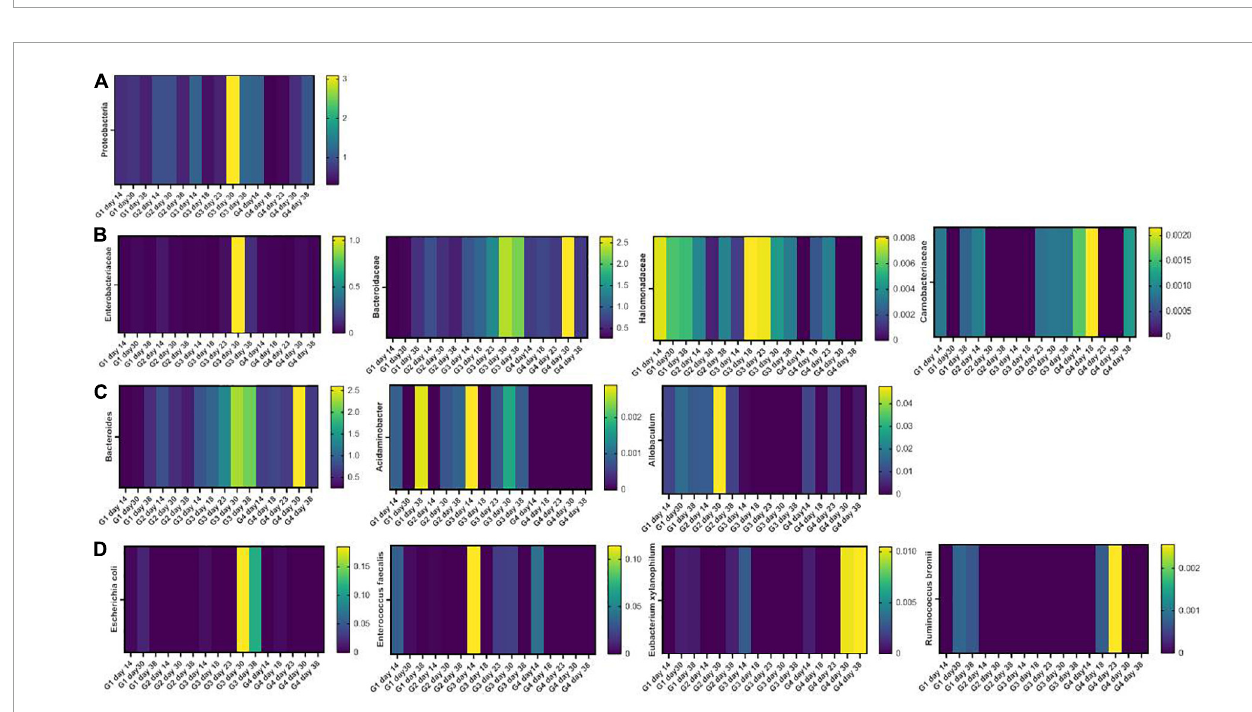
FIGURE6 Heatmaps showing the fecal microbiota composition in mice of G1, G2, G3, and G4 at the phylum (A) , family (B) , genus (C) , and species (D) level.